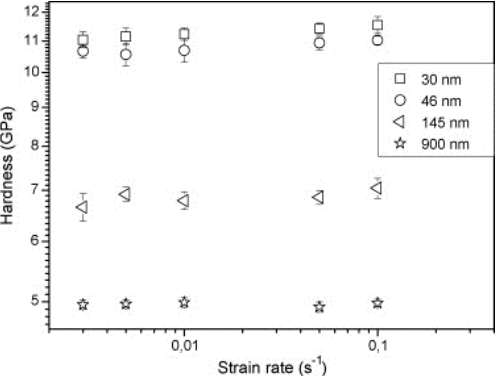
Figure 19. Nanoindentation hardness vs. strain rate for the different grain sizes [114] .